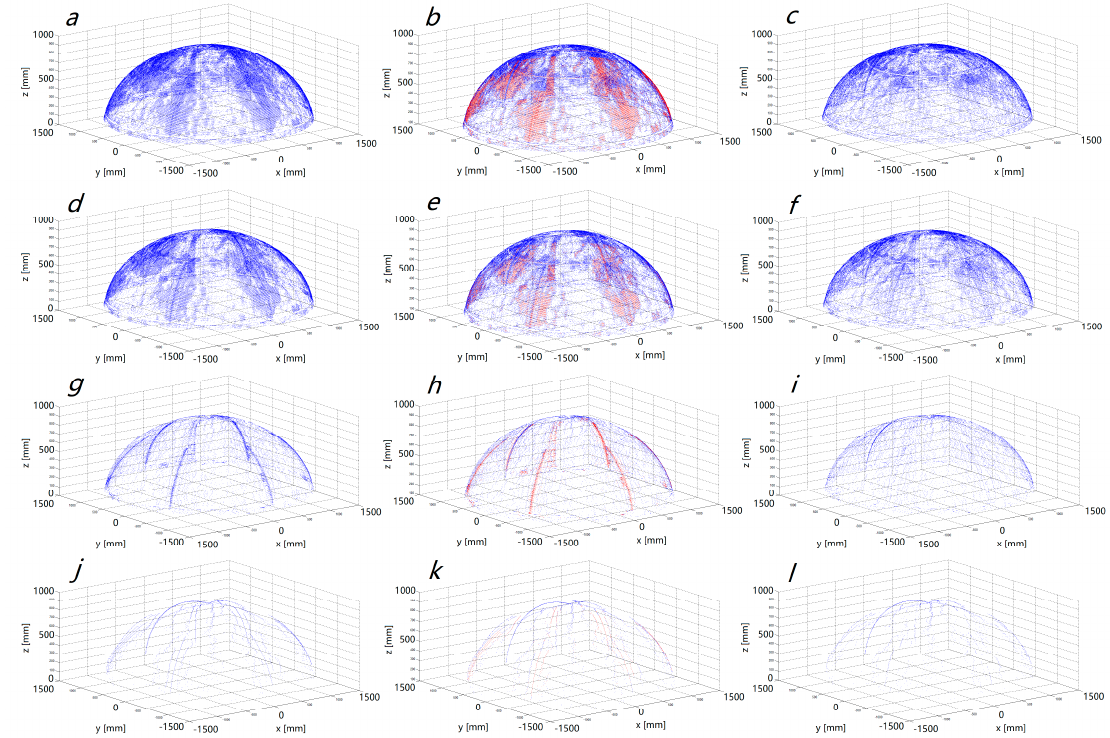
Figure 8. Spatial distributions of compressed point cloud data under different required accuracies ε :